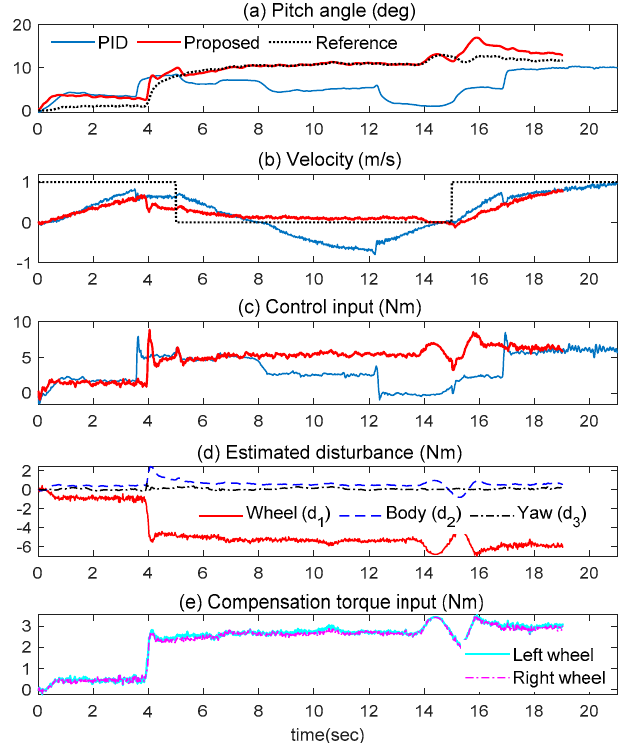
Figure 17. Holding a standstill position on the slope.